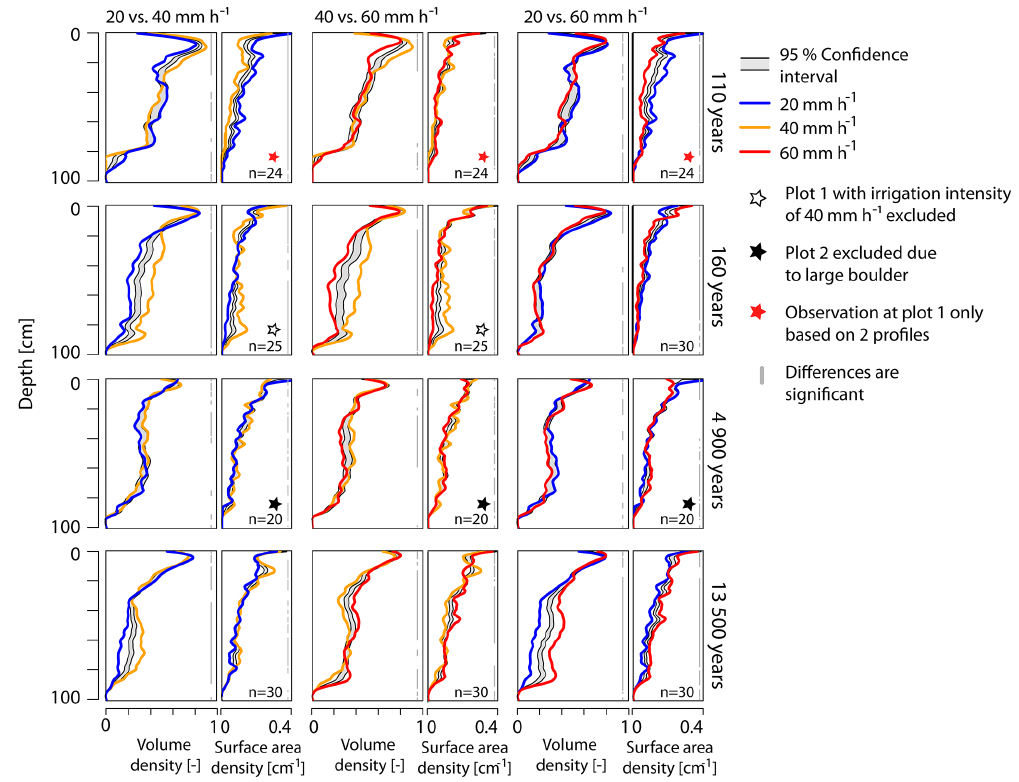
Figure 8. BLR-test for differences in volume density profiles and surface area density profiles among the three irrigation intensities per age class. If the profile lines sit outside the gray-shaded confidence interval, the two profiles are considered to be significantly different. The parts of the depth profiles where this is the case are indicated by gray vertical bars on the right of each plot. n denotes the number of profiles used for the depth-wise